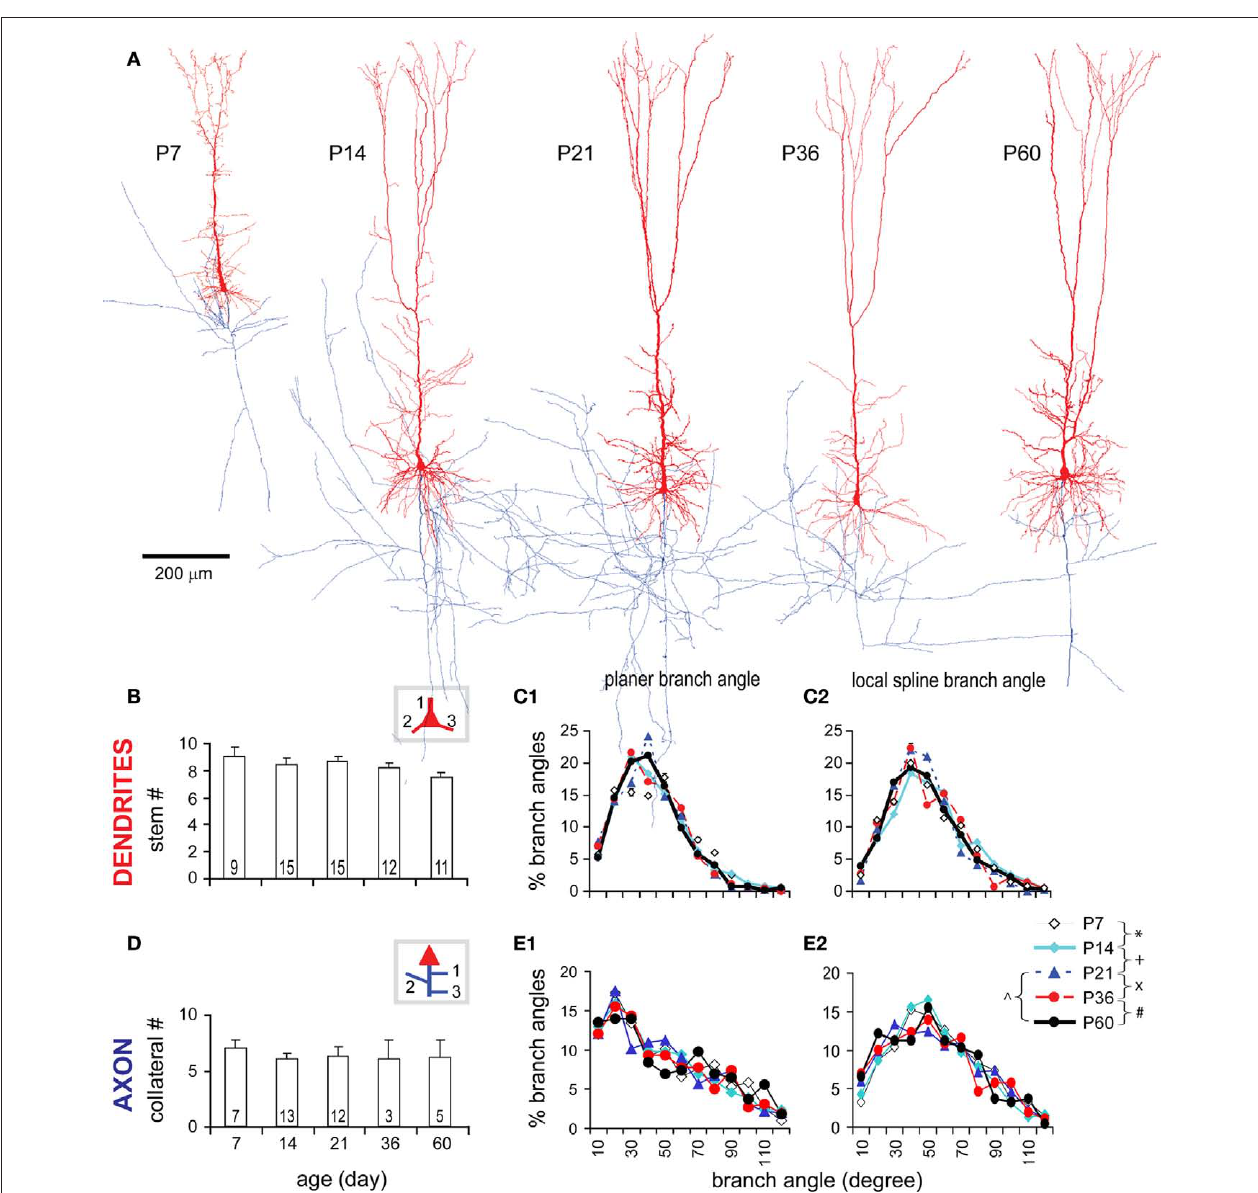
Scale bar, 200 μm. (B,C1,C2) At all ages examined, no significant changes were tested in the number of dendritic stems and the dendritic branch angles that include planer branch angle (PBA) and local spline branch angle (LSBA). (D,e1,e2) At all ages examined, no significant changes were tested in the number of collateral stems (emerged from main axon) and in the axonal PBA and